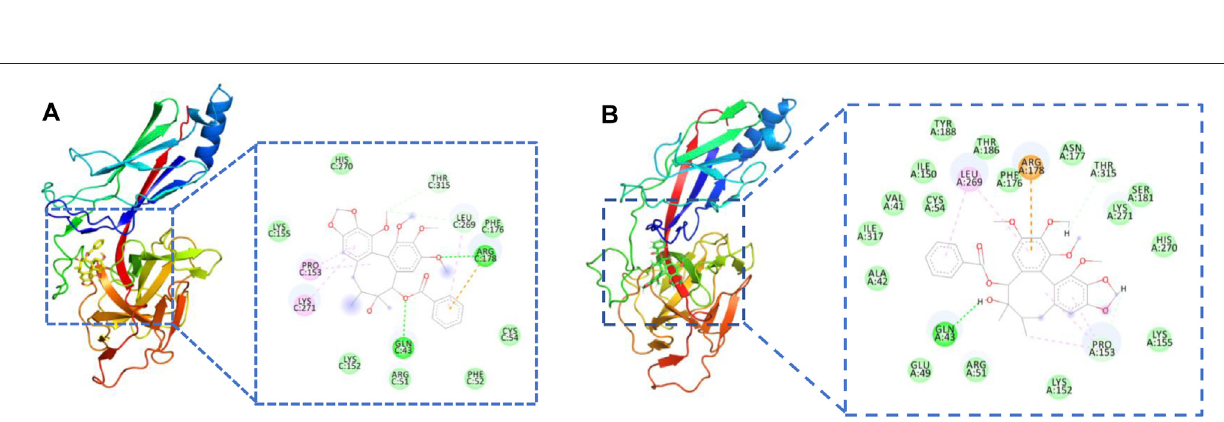
Frontiers in Pharmacology |